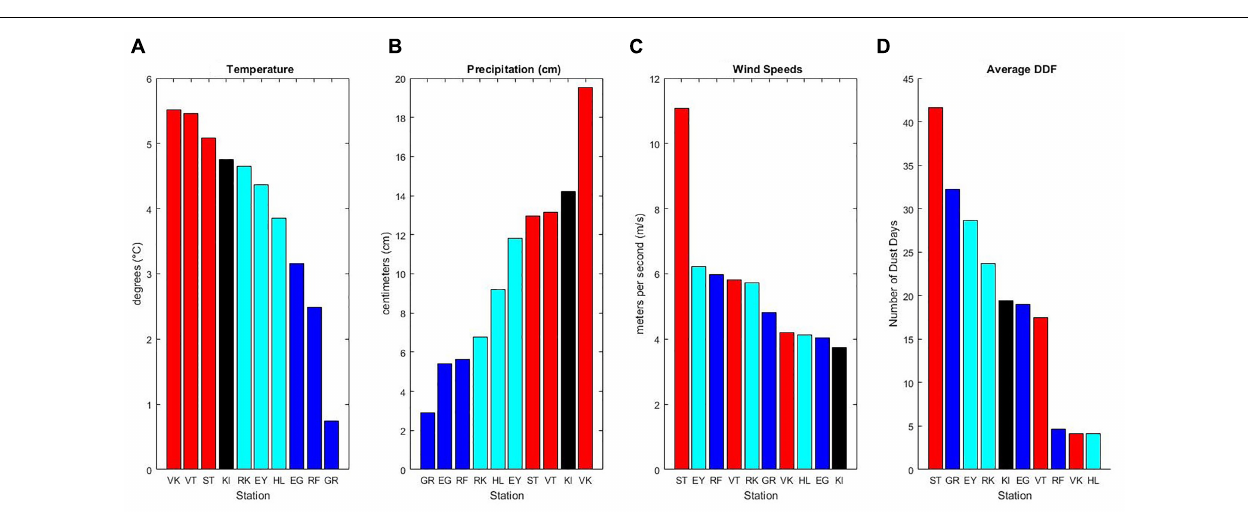
Frontiers in Earth Science |